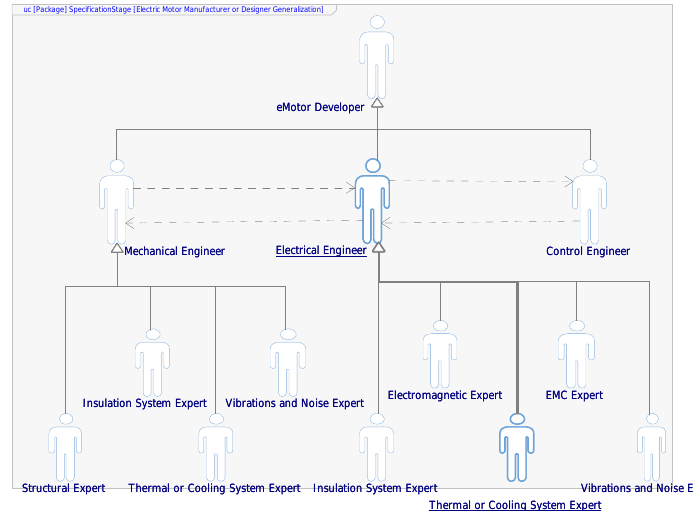
Figure 1 . Generalization of the electric motor developer. Figure 1. Generalization of the electric motor